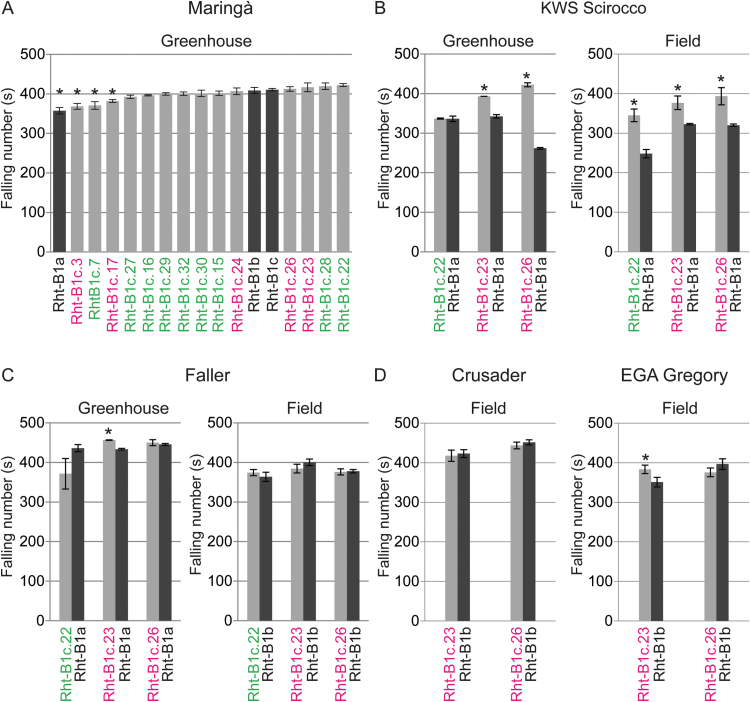
Effect of ovg alleles on falling number, independent of PHS, in different cultivars in the greenhouse and field. Average falling numbers ±SE are shown (n=3). * indicates a significant difference (P<0.05) from the reference allele, namely Rht-B1c for Maringá (A); Rht-B1a for KWS Scirocco (B); Rht-B1b for Faller (C), as well as for Crusader and EGA Gregory (D). Tall alleles are in green and semi-dwarf alleles are in magenta. For KWS Scirocco and Faller, results were confirmed in at least two sister line pairs, each derived from an independent BCF1 plant. For KWS Scirocco, results were additionally confirmed in a field trial in 2014 (Supplementary Fig. S4).